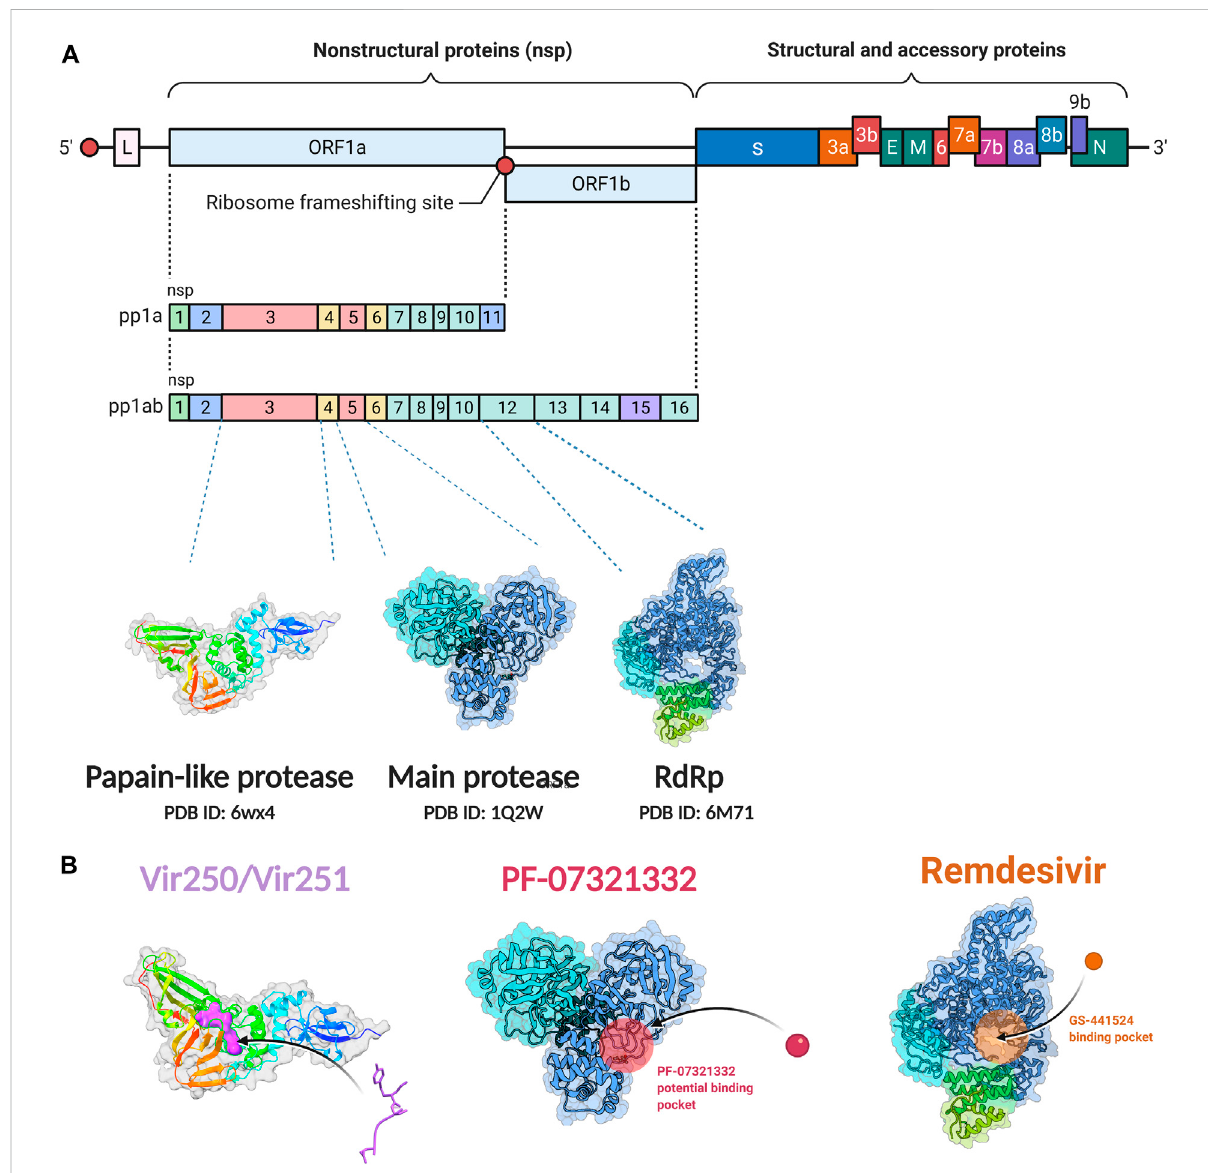
FIGURE 1 Non-structural protein as targets for antiviral drug development. (A) Genome organization of SARS-CoV-2. (B) The crystal structure of the non-structuralproteinsandtheirinhibitors.ThecrystalstructureofVIR250andVIR251incomplexwithPLproofSARS-CoV-2;thecrystalstructureof Mpro and its binding pocket of PF-07321332; the crystal structure of RdRp and its binding pocket of remdsivir. The crystal structures were obtained from RCSB Protein Data Bank. Figure was generated by